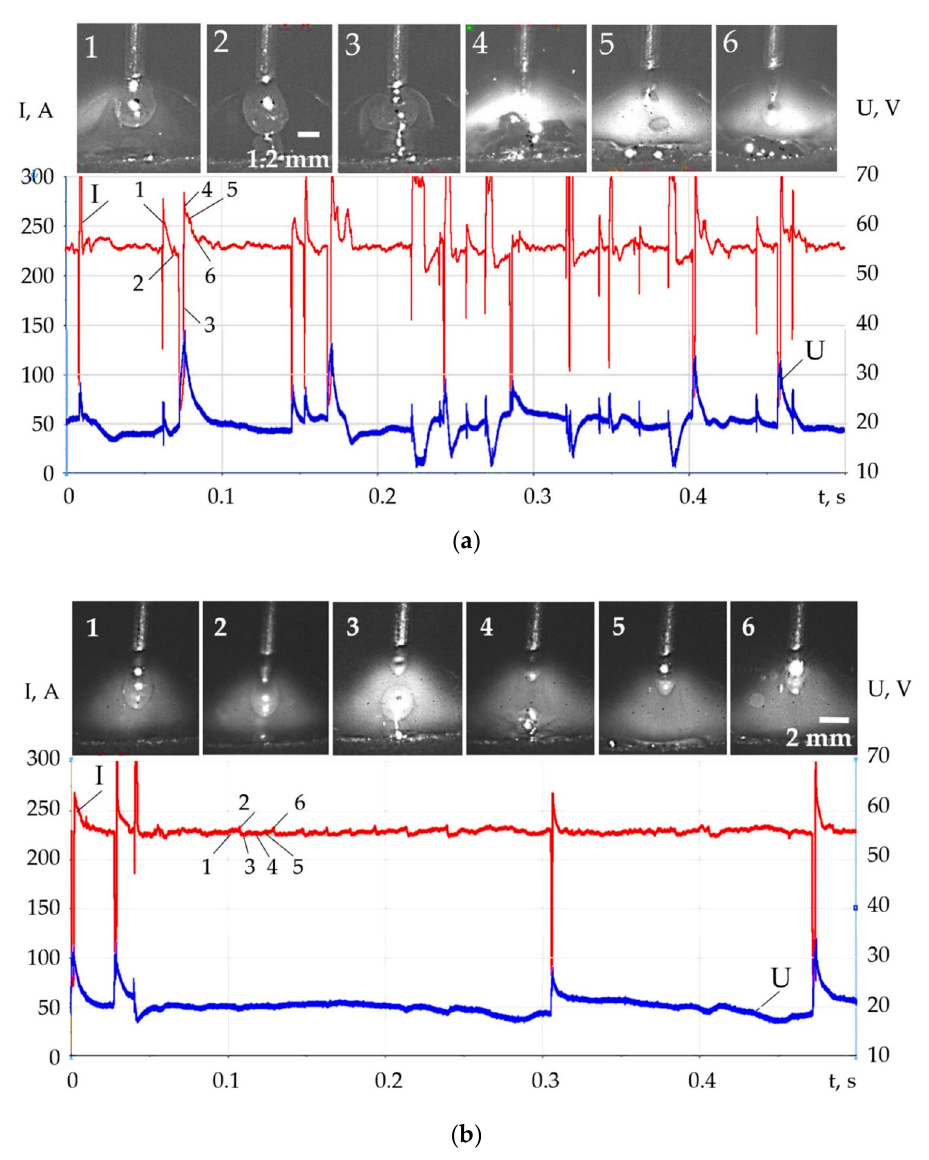
Figure 10. Change in current and sequence of droplet transfer during melting of G3Si1 wire of 1.2 mm in argon: ( a ) uncoated wire; ( b ) wire with Ni-LaF 3 coating of 5 μ m; time between the frames is 5 ms; 1–6 is a sequence of frames.